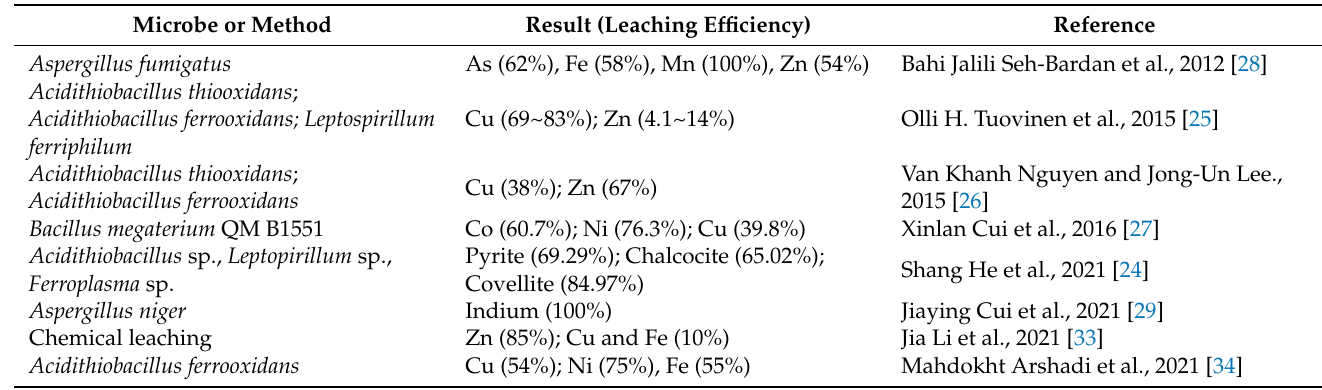
Table 1. The advance in leaching metals technological